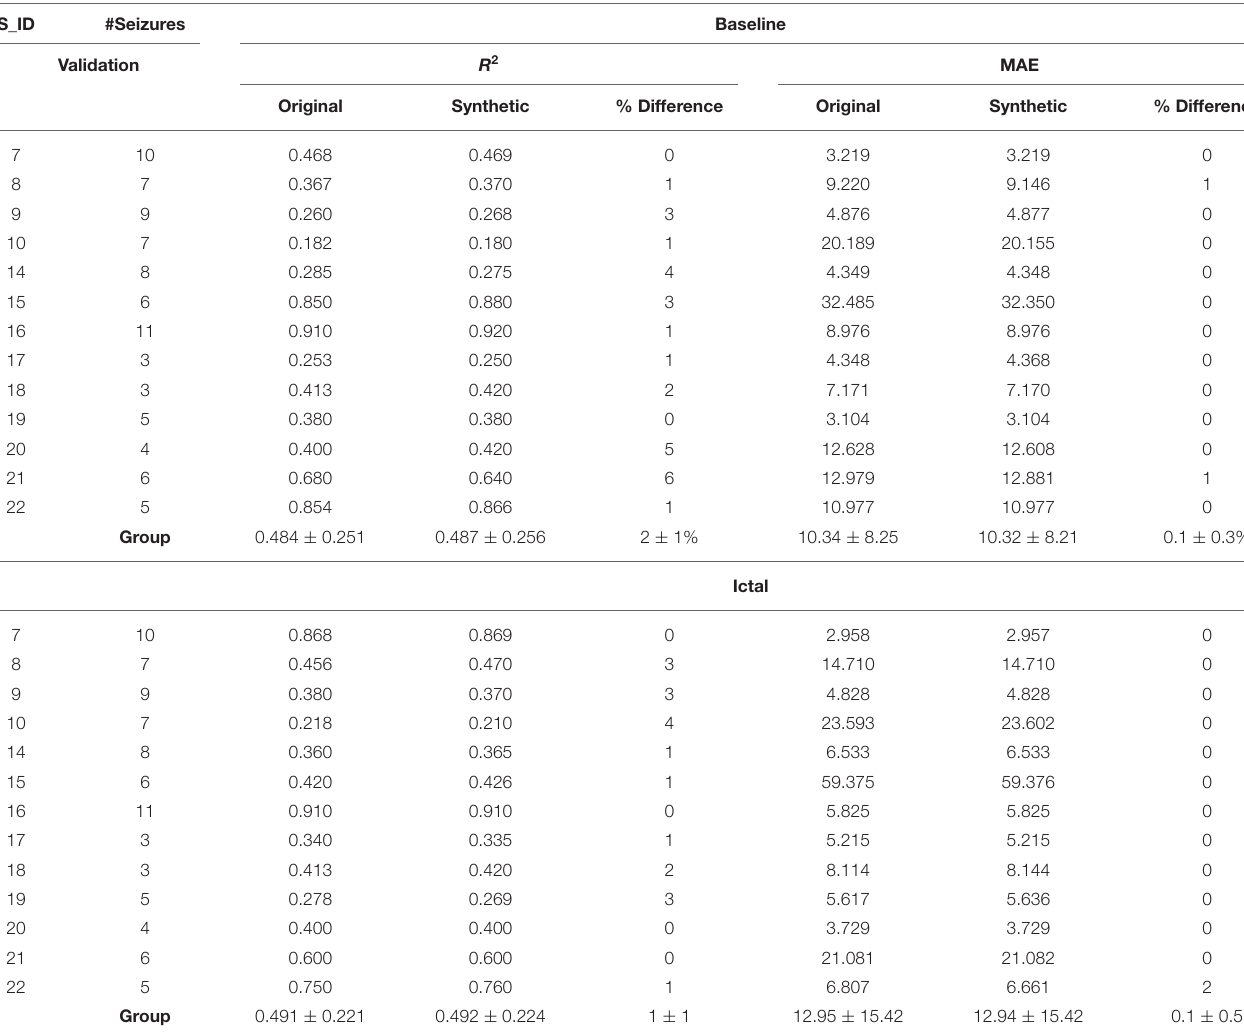
TABLE 2 | Coefficient of determination (R2) and mean absolute error (MAE) values obtained from regression models comparing original and synthetic data for the baseline and ictal data. S_ID #Seizures Baseline